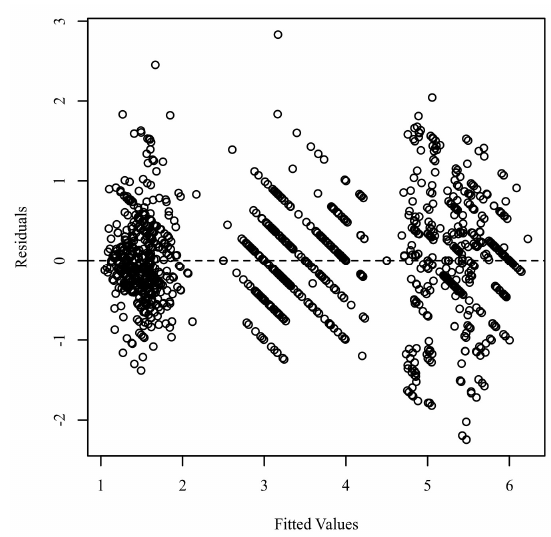
Figure 1. Residuals scatterplot testing homoscedasticity.